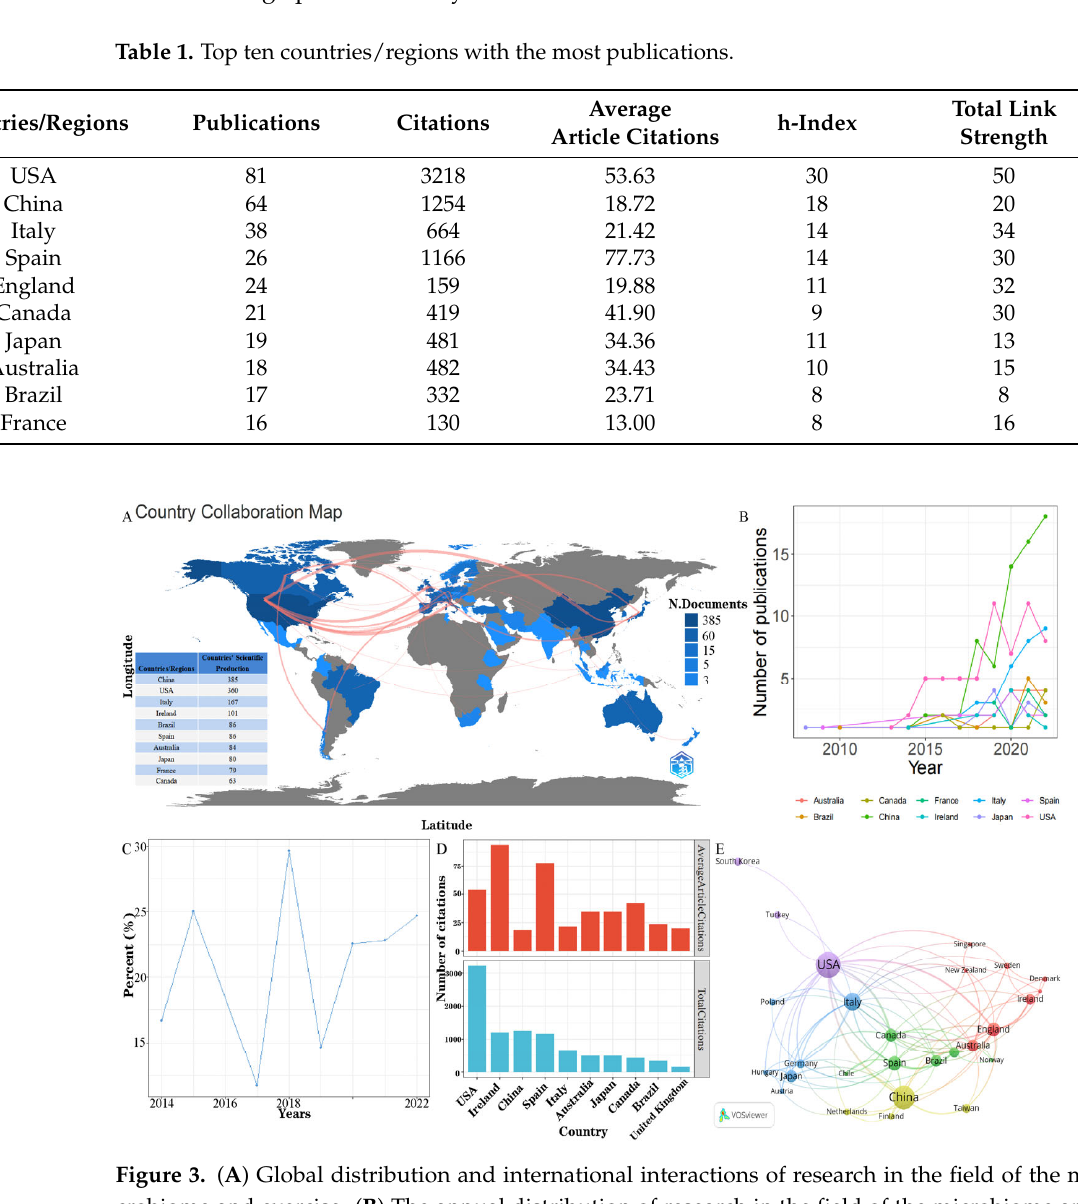
est number of times cited (1043), followed by Paris ‐ Saclay University, from France (9 pub ‐ lications with 556 times cited), Sapienza University of Rome, from Italy (7 publications